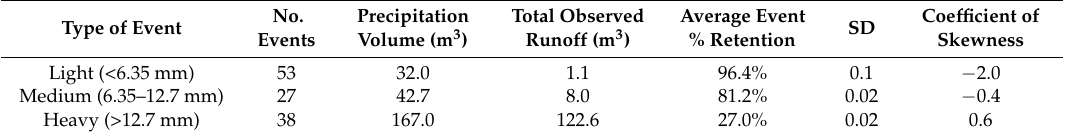
Table 5. Observed JGR storm